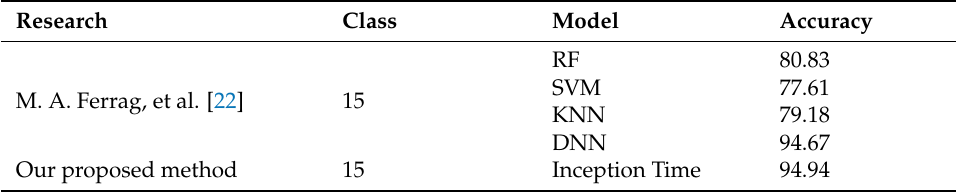
Table 9. Comparison of the results with previous studies using the Edge-IIoT